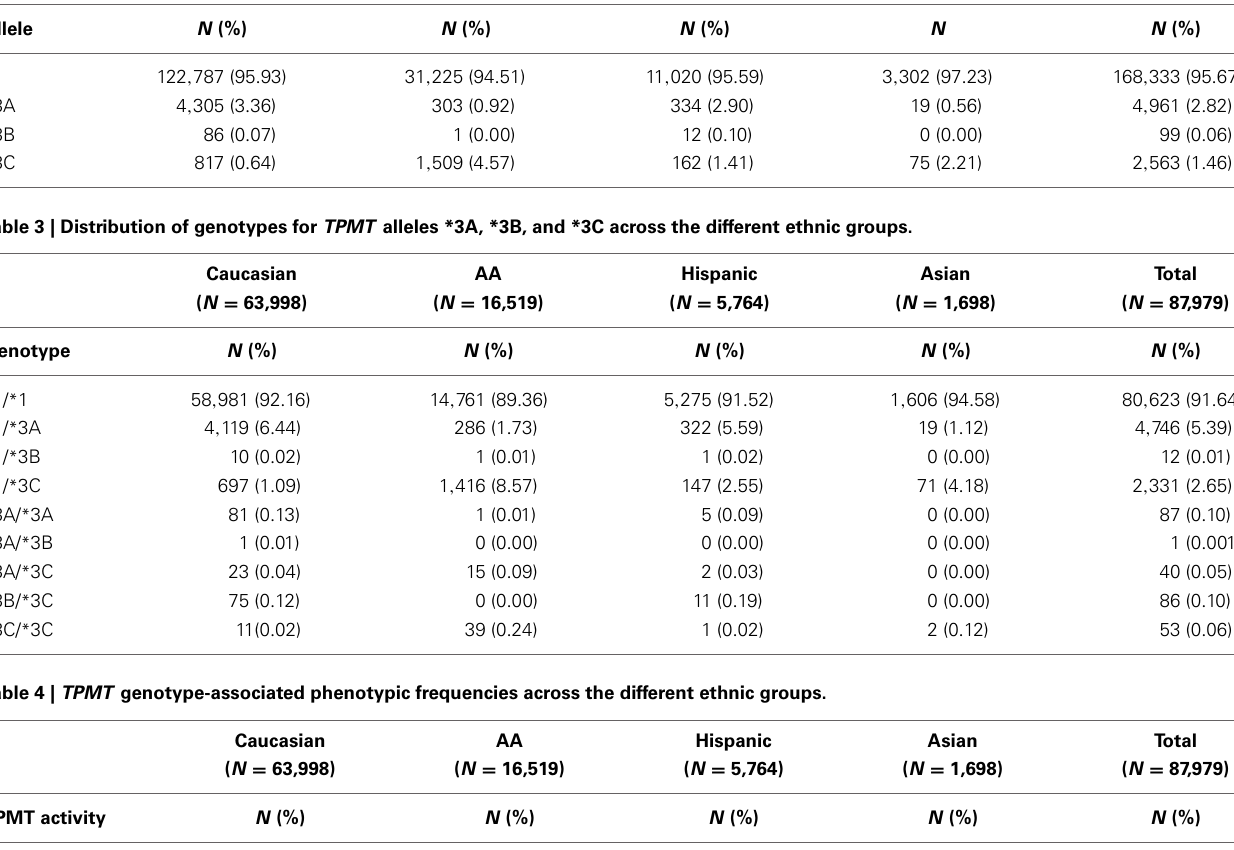
Table 2 | Distribution of allele frequencies for TPMT alleles *3A, *3B, and *3C across the different ethnic groups. Caucasian AA